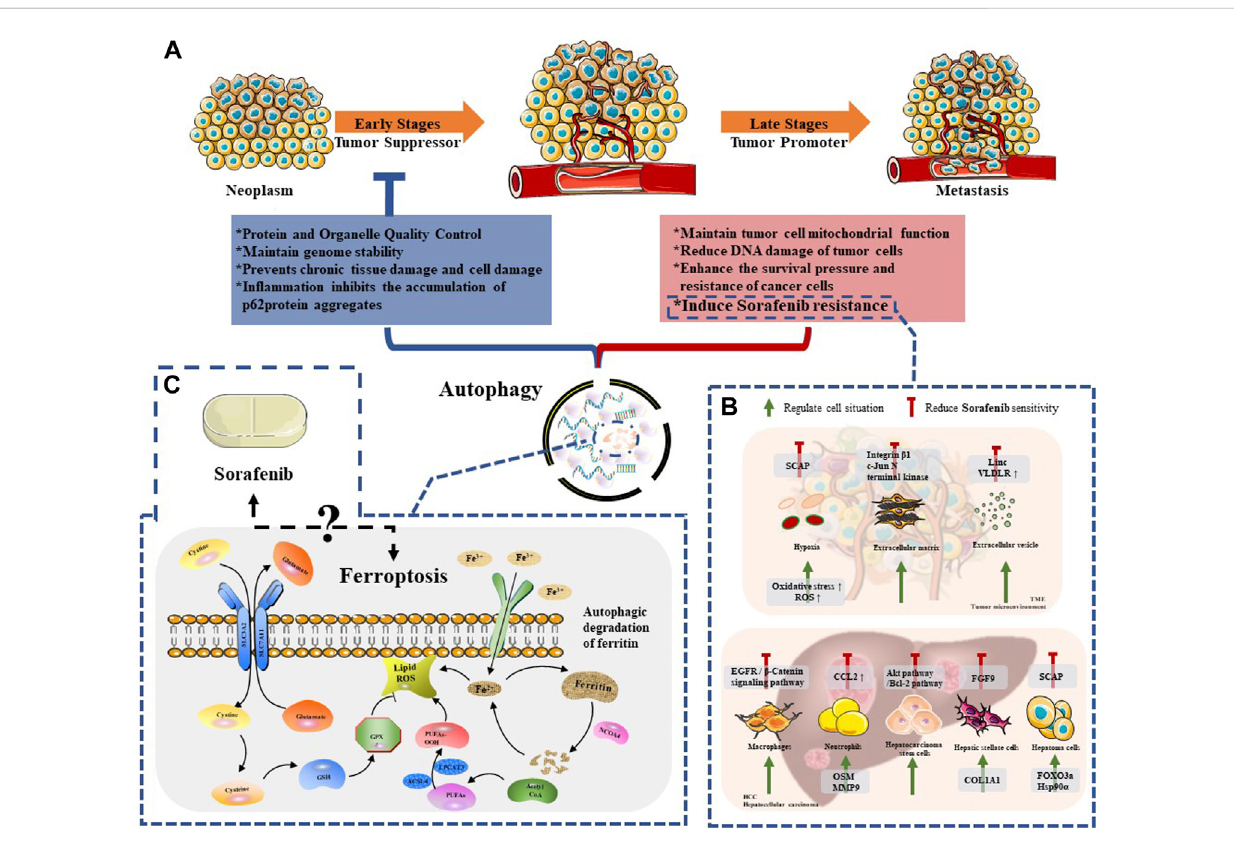
FIGURE 2 TherelationshipbetweenautophagyandSorafenibtherapy. (A) Theduleroleofautophagyinneoplasmprogression; (B) Theregulationmechanisms ofautophagyamongHCC cellsand TMEcompartments,which reduced Sorafenib sensitivity; (C) The mechanism offerroptosisand theremainingissues between this special mode of autophagy and